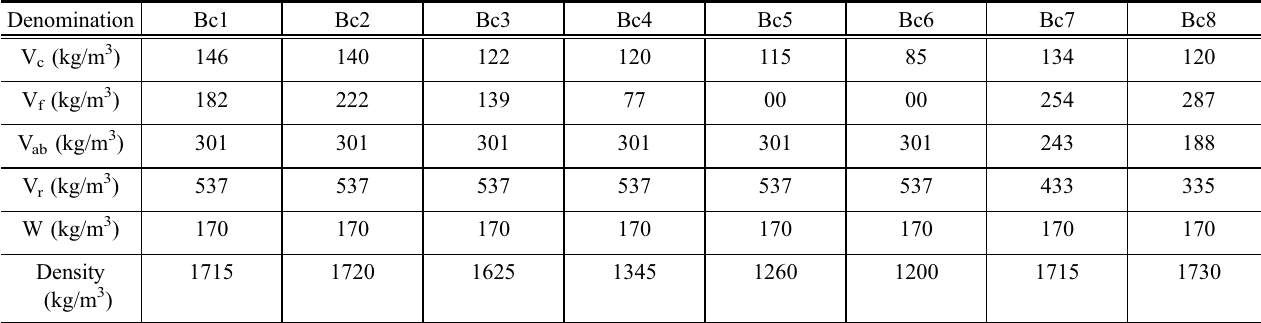
Table 4 Binary concretes